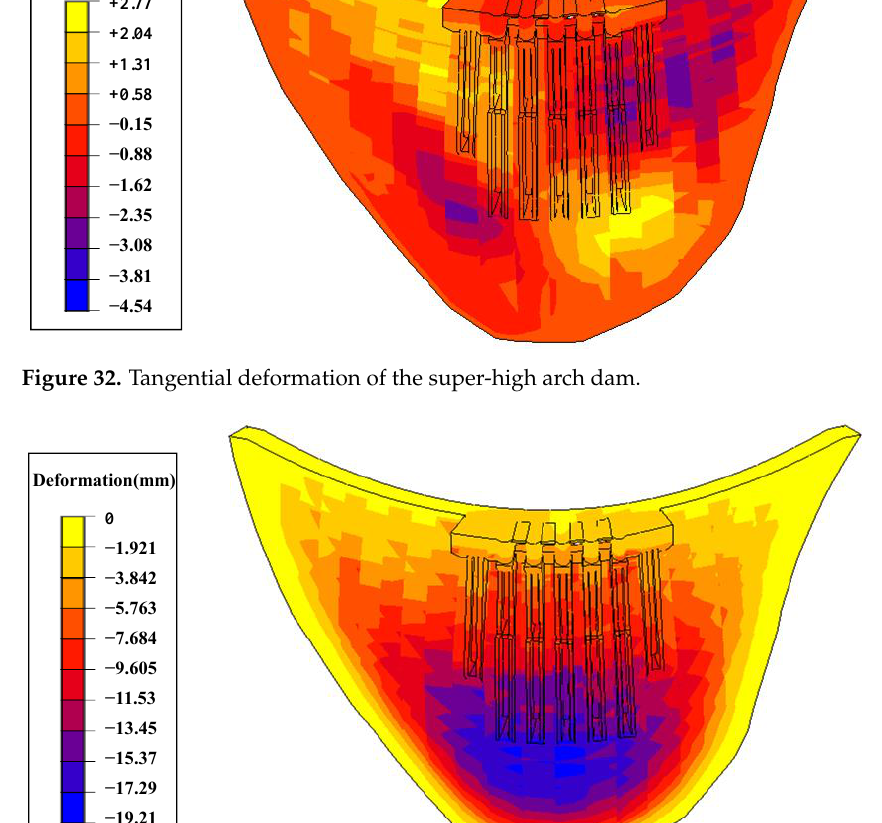
Figure 33. Vertical deformation of the super-high arch dam.